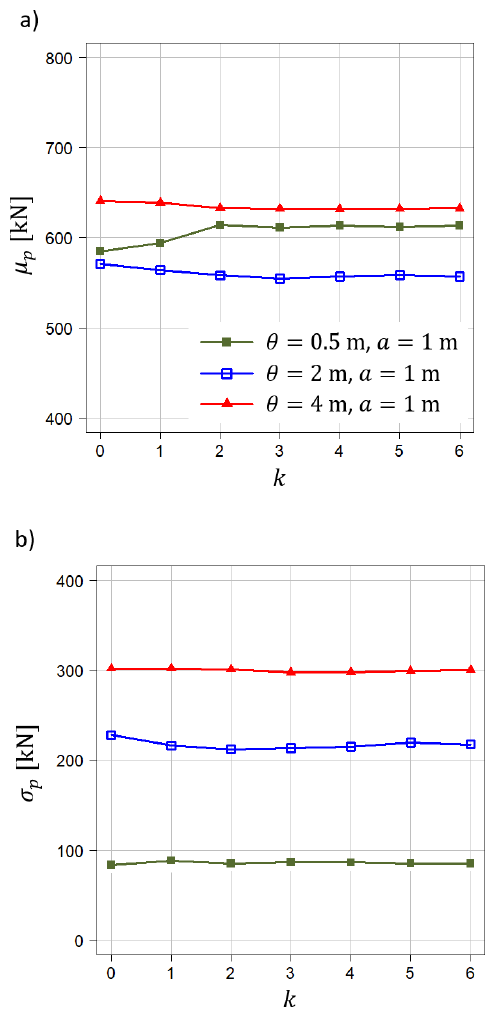
Figure 7: Bearing capacity mean values as a function of covariance matrix iteration number (a). Bearing capacity standard deviations as a function of covariance matrix iteration number (b). Case k =0 is for the constant covariance matrix. Results for a square foundation of size 1 m x 1